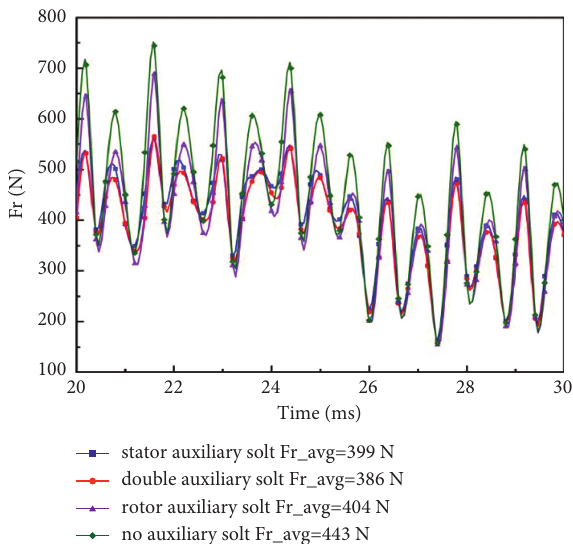
Figure 4: Radial EMF versus time for difference SRM models.